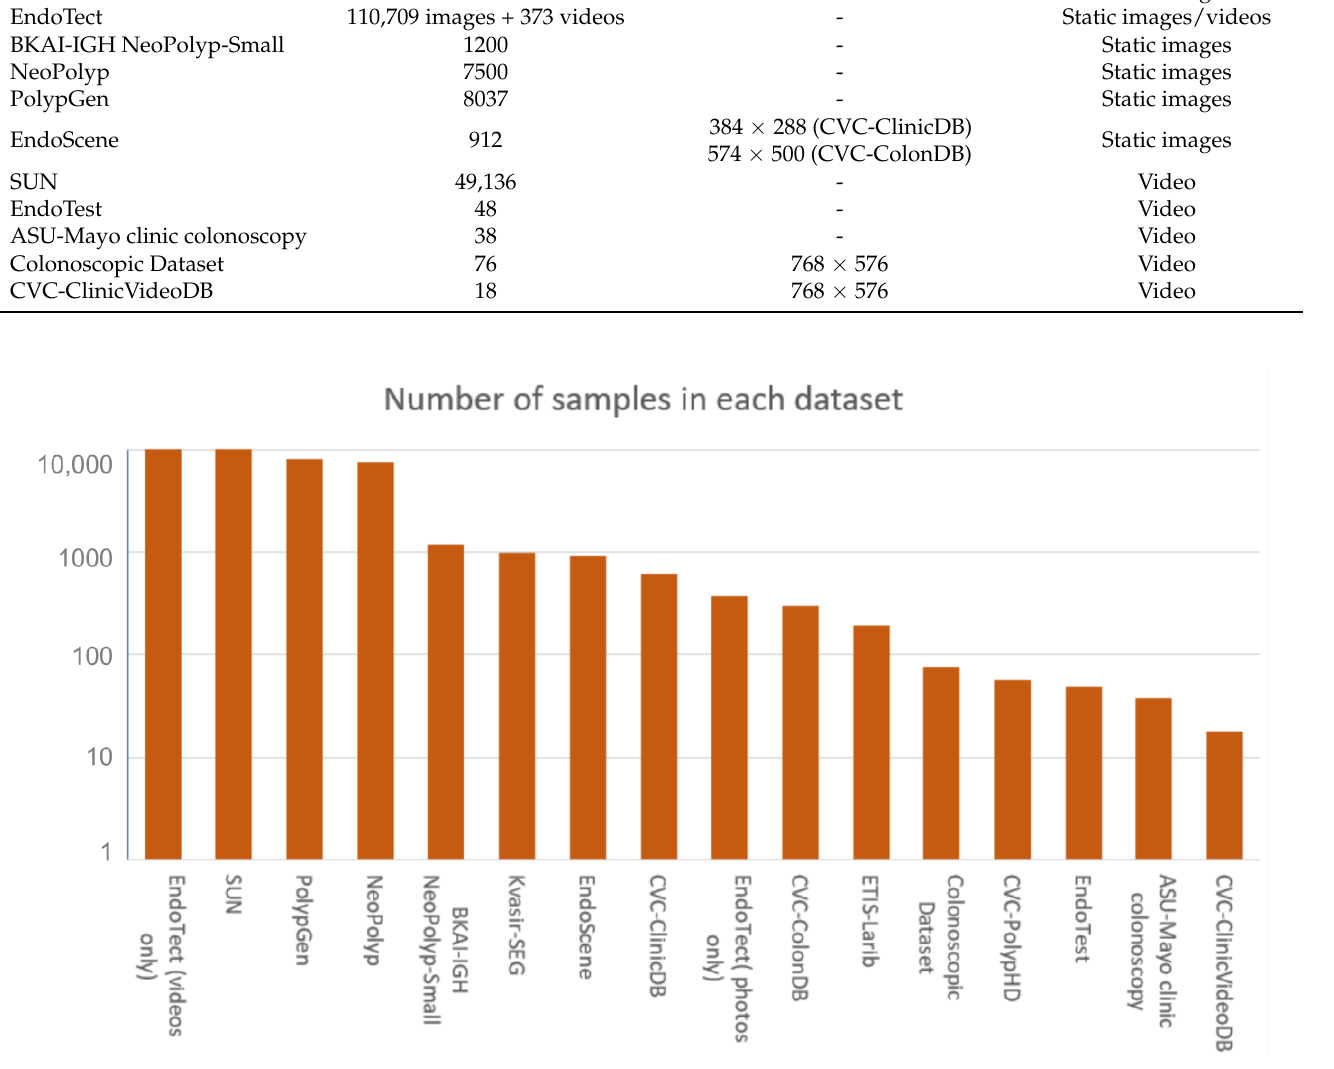
Figure 3. T otal number of samples in every dataset